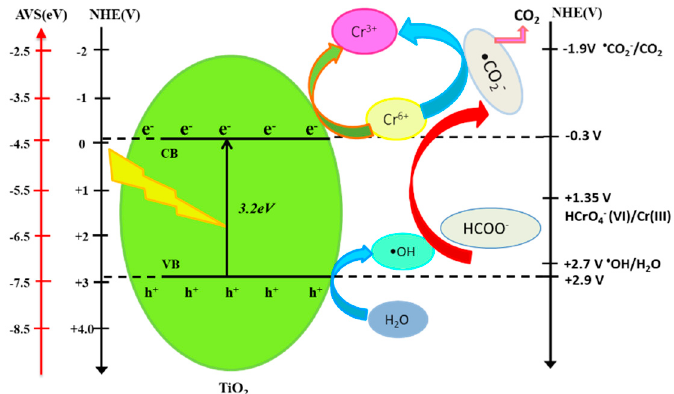
Table 1. Kinetic parameters for the photocatalytic reduction of Cr(VI). Commercial TiO 2